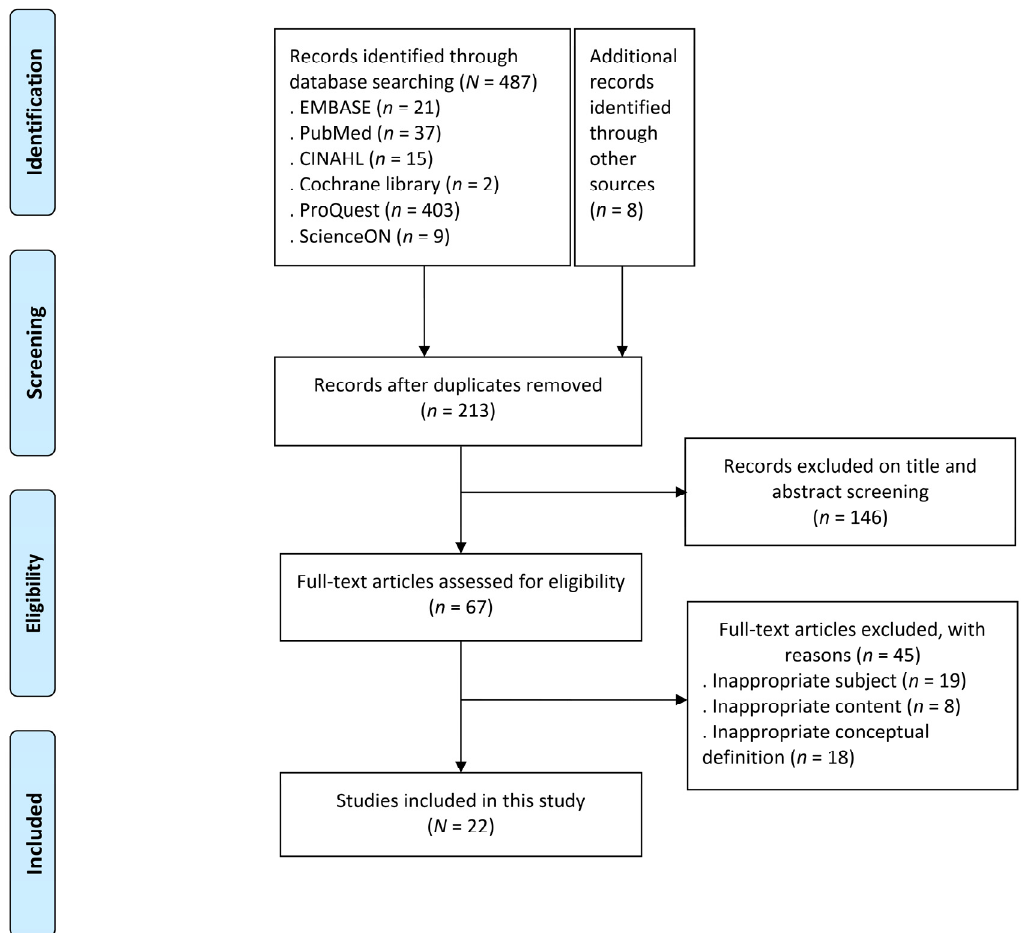
Figure 1. Flow diagram of study selection process.